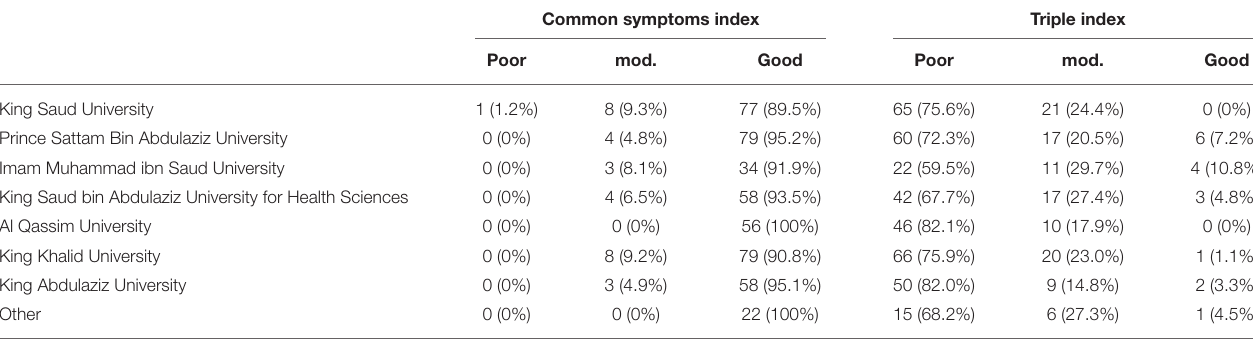
TABLE 4 | Frequencies for symptoms and triple index categorization in